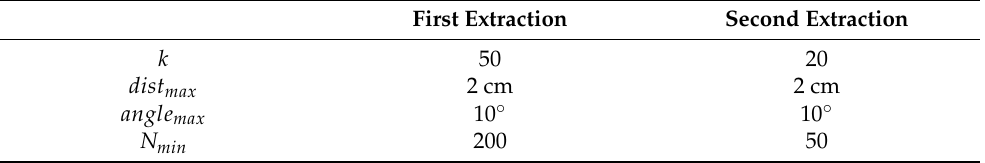
Table 1. Parameters for piece-wise planar segments extraction. We extract the planar surfaces iteratively to extract more smaller and detailed planar surfaces. At the first iteration large planar surfaces are extracted, whereas at the second iteration small planar surfaces are